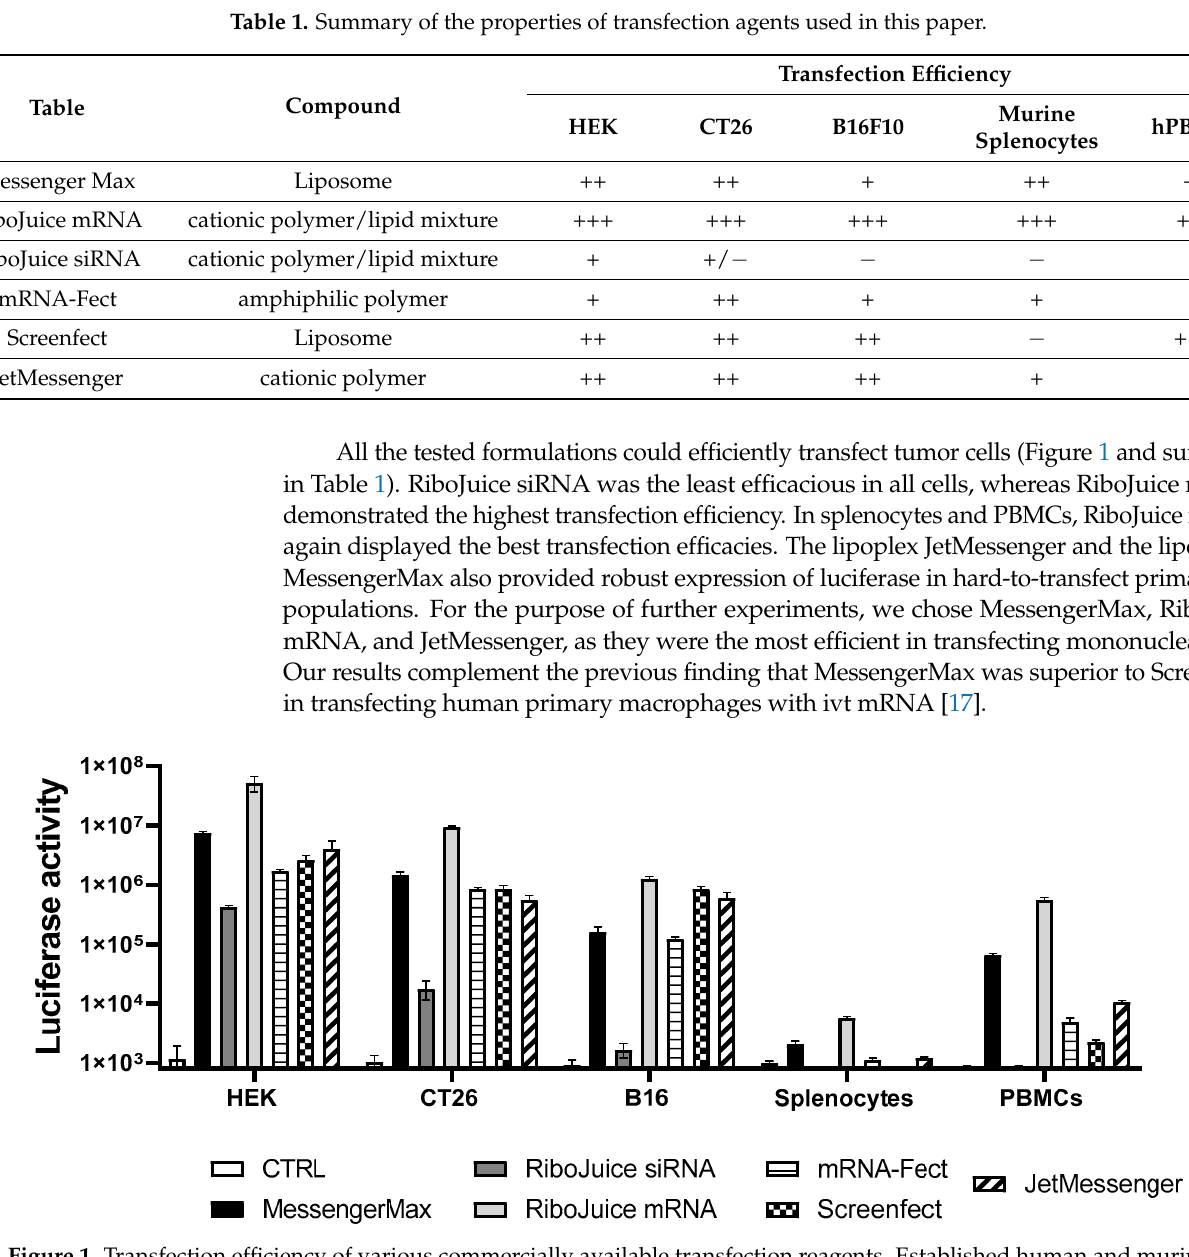
Table Table 1. Summary of the properties of transfection agents used in this paper.